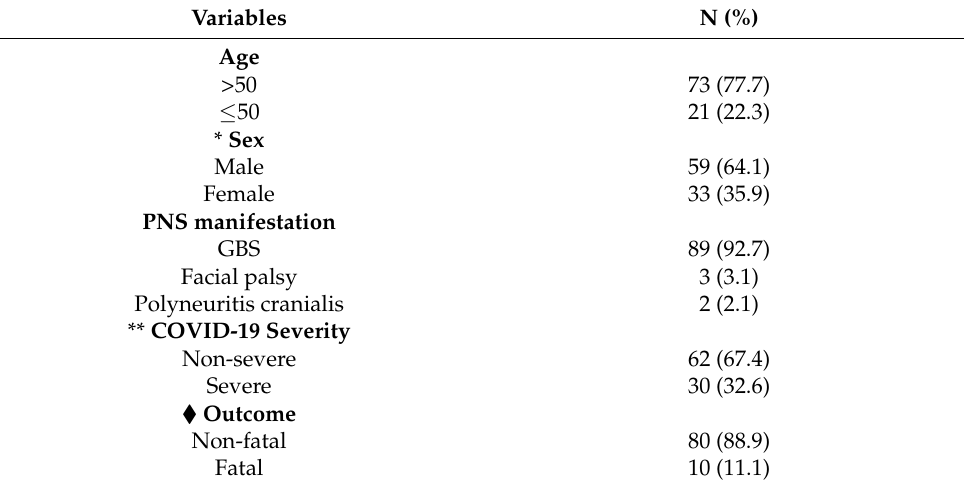
Table 6. Demographics and PNS manifestations in the 94 patients.